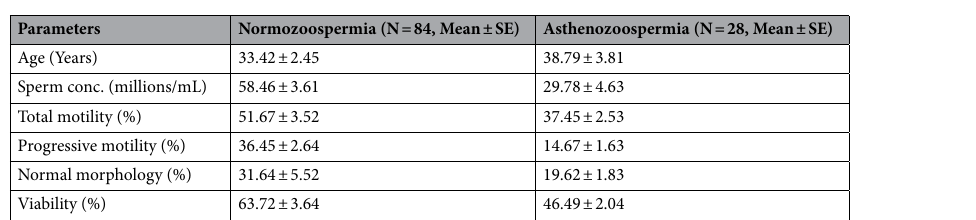
Table 2. Semen characteristics of subfertile